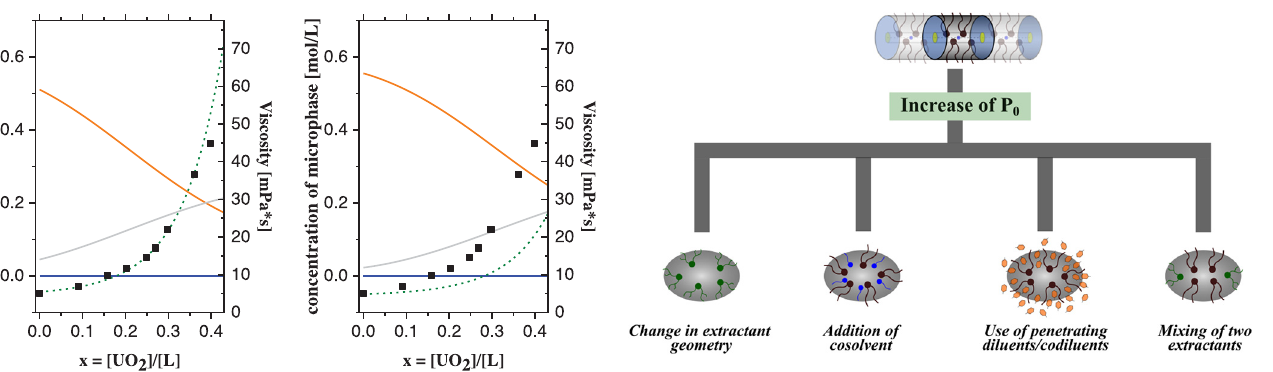
Fig. 17. Left: simulated (green dashed) and experimental viscosity (black spheres) of 1.5M DEHiBA applying a variation of the spontaneous packing parameter from 2.6 to 2.0, k *= 3 kT/ extractant and an effective extractant concentration of 1.2M. Right: simulated viscosity (green dotted) applying additionally a solvent penetration of 3%. For both cases, additionally the microphase distribution of end-caps (orange), cylinders (grey) and junctions (blue) is shown.